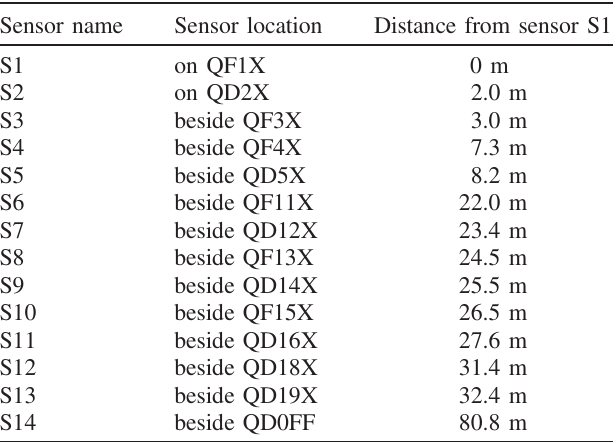
TABLE I. Overview of the 14 chosen sensor